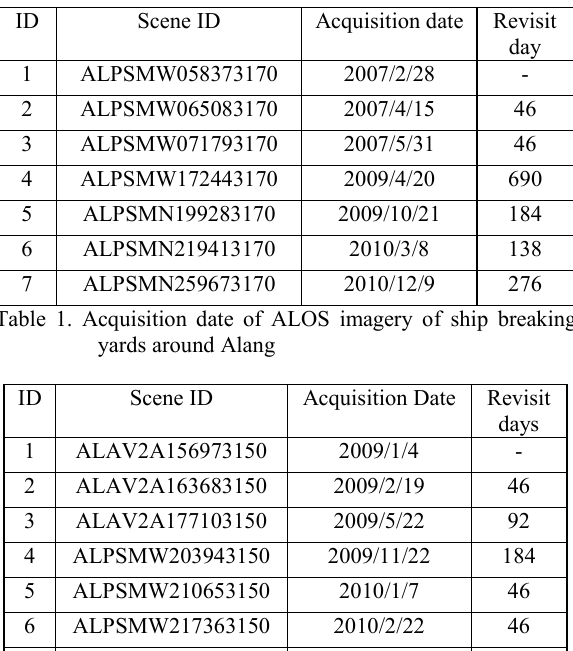
Figure.3 shows example of counted ships and breaking vessels figure in experimental area in Chittagong.